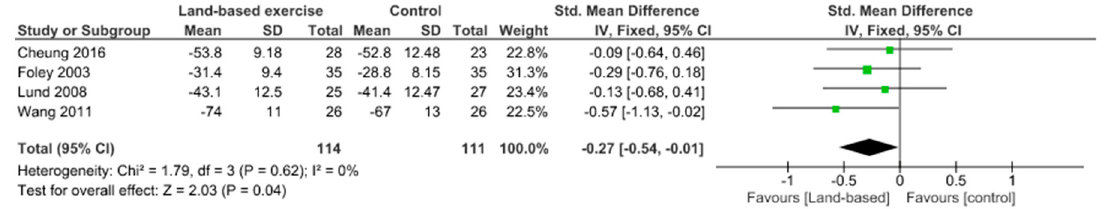
Figure 14. Quality of Life: Land-based exercise versus Control.